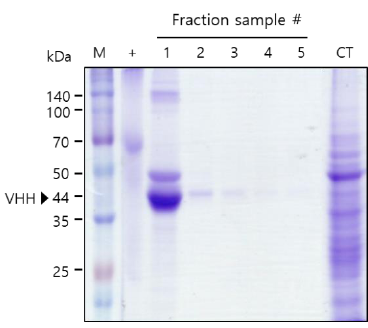
Figure 2. Sodium dodecyl sulfate polyacrylamide gel electrophoresis (SDS-PAGE) to confirm the purification of anti-HER2 VHH-FcK from tobacco leaf. Confirmation of the purified anti-HER2 VHH- FcK P using SDS- PAGE. M: protein marker; +: positive control, BSA (2 μg); 1 -5: anti-HER2 VHH-FcK fraction samples; CT: column flowthrough.